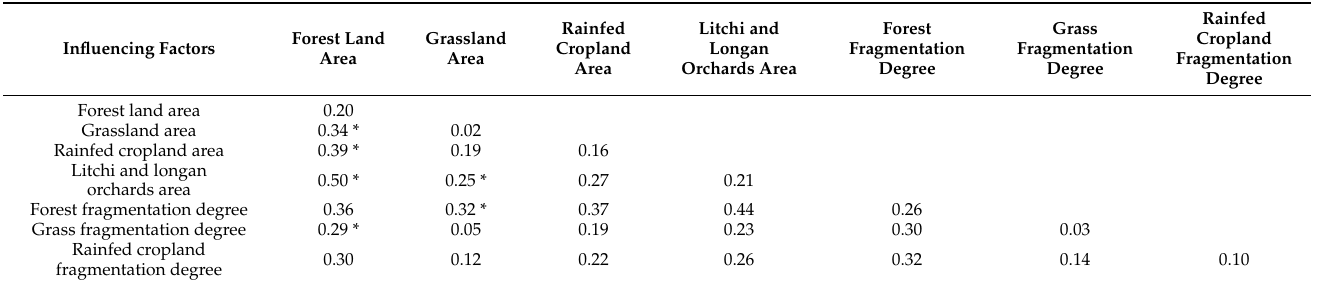
Figure 5. Spatial distribution of hotspots of the wild bees of longan and litchi in the study region in 2015–2019. ( a ) 2015; ( b ) 2019. Table 4. Interaction between influencing factors on the pollination services for litchi and